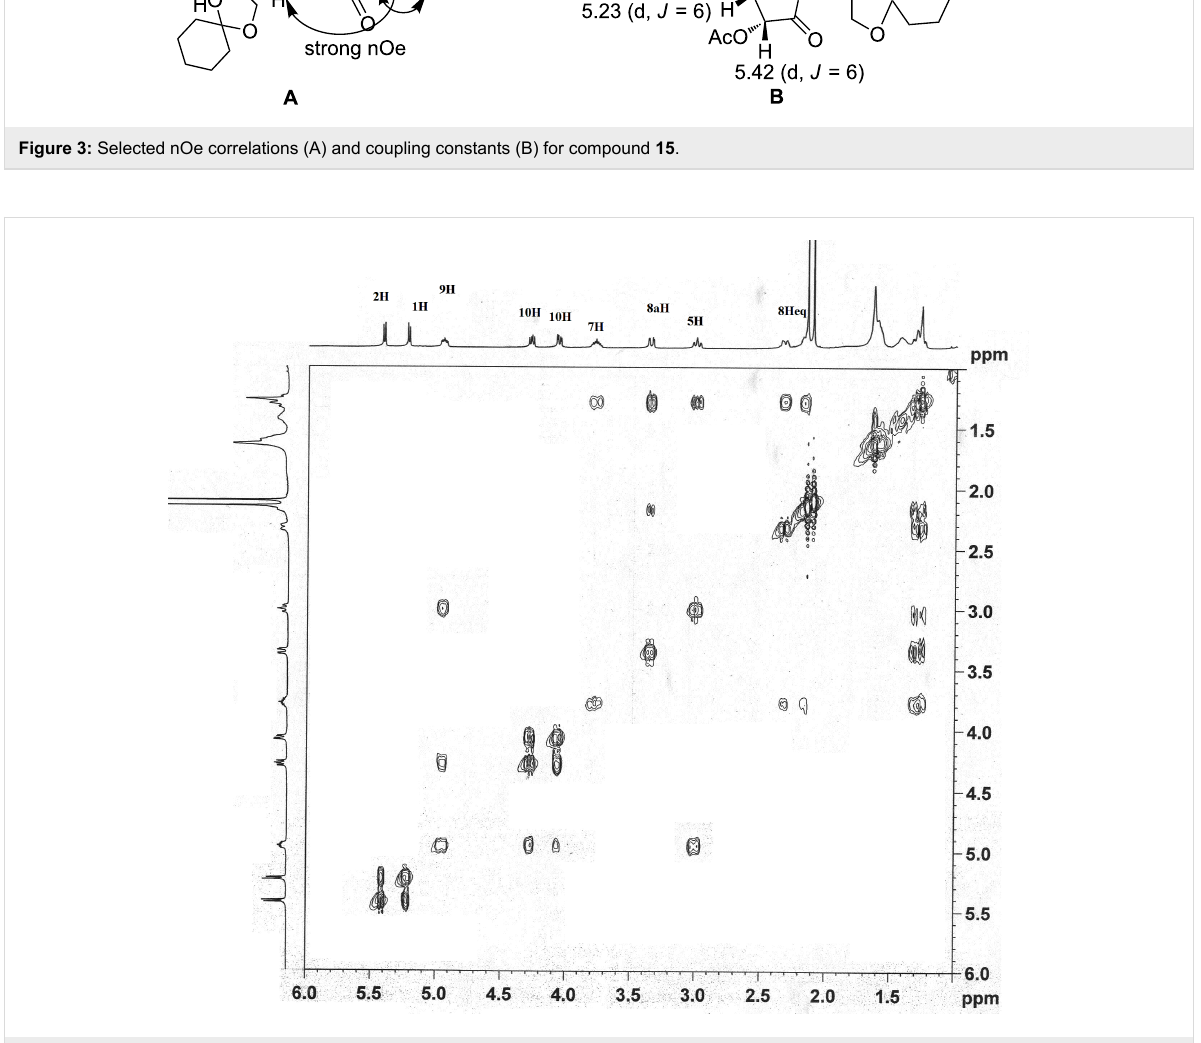
Figure 4: 1 H, 1 H COSY spectrum of compound 15